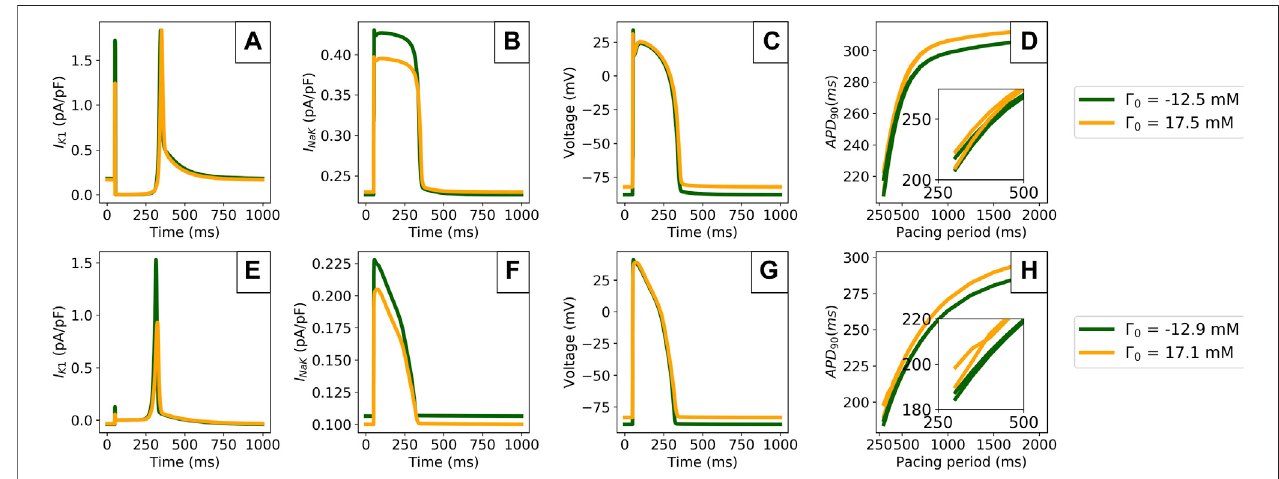
FIGURE 7 | Comparison of model predictions in the periodic steady state outputs for the extreme values of Γ 0 computed from Section 3.2 . Data is shown for the TTP06 (top row) and ORd-CiPA models (bottom row). (A,E) : I K1 current. (B,F) : Sodium-Potassium exchanger (I NaK ) current. (C,G) : AP. (D,H) : Limit cycle restitution portraits showing APD 90 variation with the pacing period. The insets show pacing cycle lengths of 500 ms and shorter.